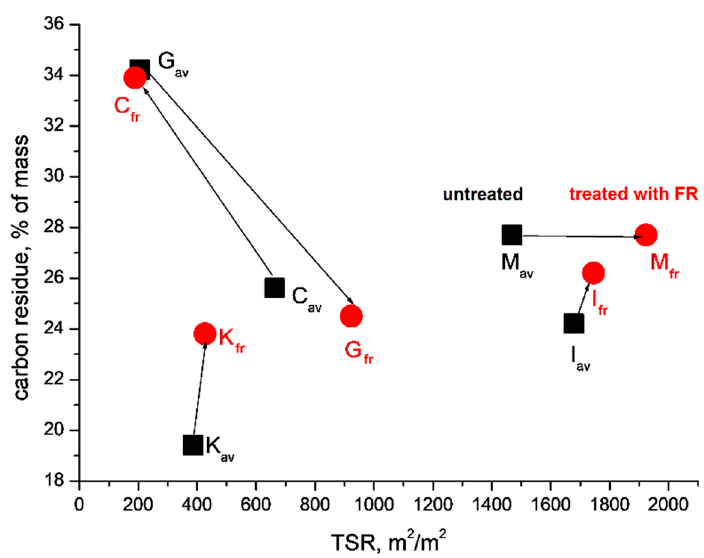
Figure 11. Correlation between carbon residue after sample extinction and total smoke release.